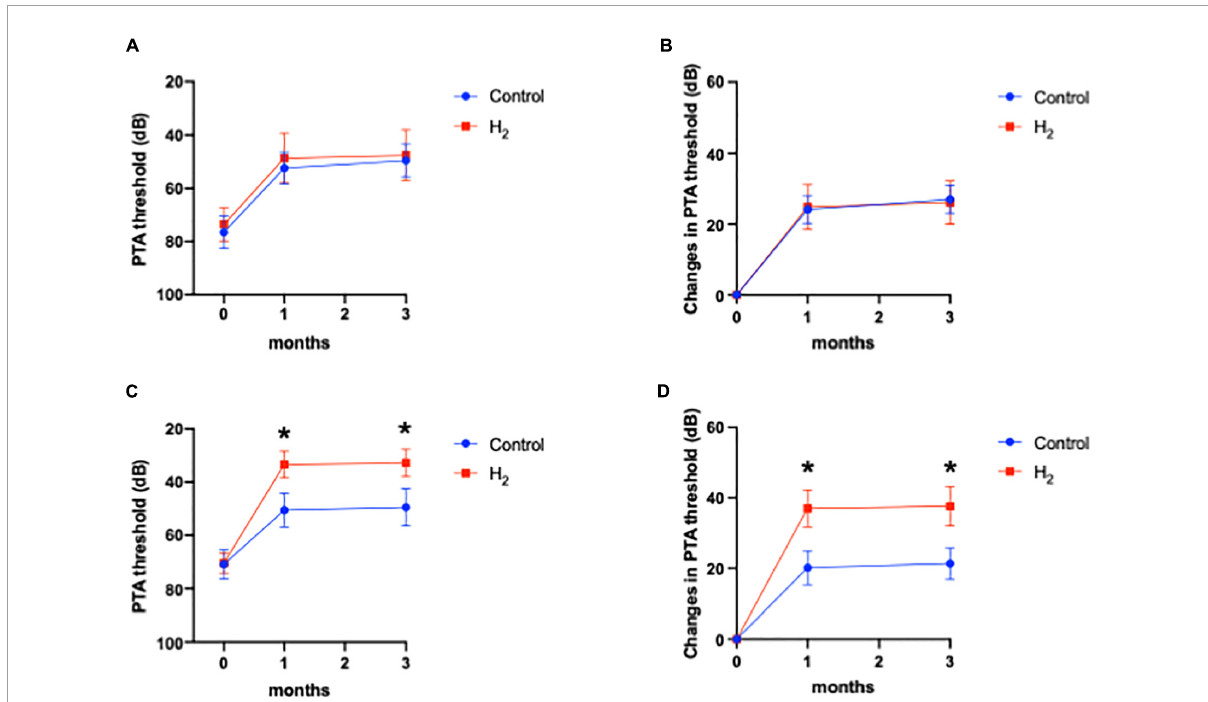
FIGURE7 Hearing outcomes depending on hypertension. (A) PTA threshold among patients with hypertension. (B) Changes in the PTA threshold among patients with hypertension. (C) PTA threshold among patients without hypertension. (D) Changes in the PTA threshold among patients without hypertension. Although the effect of H 2 gas inhalation was not observed in patients with hypertension, hearing outcomes were significantly improved in the H 2 group among patients without hypertension. * P <